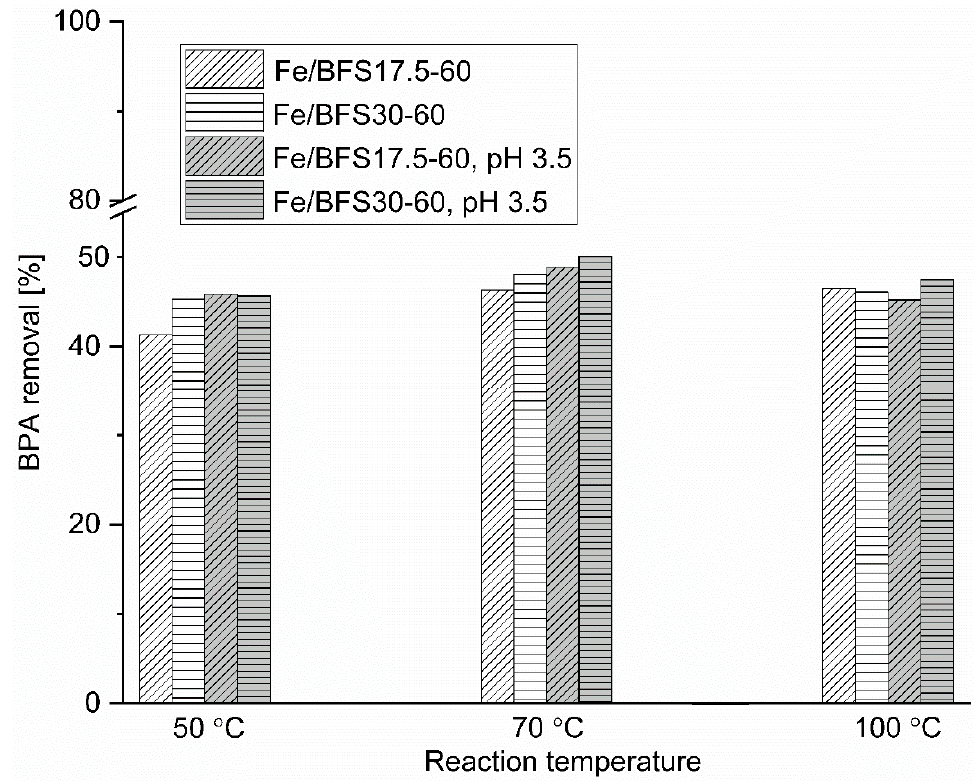
Figure 5. Bisphenol A removal at reaction temperatures of 50 °C, 70 °C, and 100 °C with the Fe/BFS17.5-60 and Fe/BFS30-60 catalysts, at an initial pH of 3.5, a reaction time of 3 h, [BPA] = 60 mg/dm 3 , c [H 2 O 2 ] = 1.5 g/dm 3 , and c [catalyst] = 4 g/dm 3 .